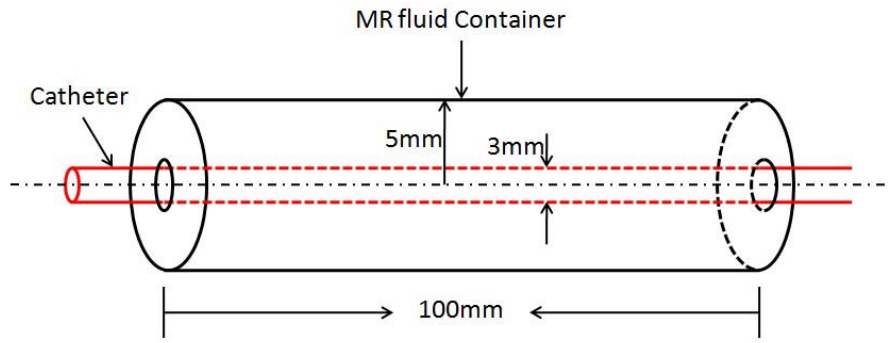
Figure 5. Schematic diagram of the MR fluids container.